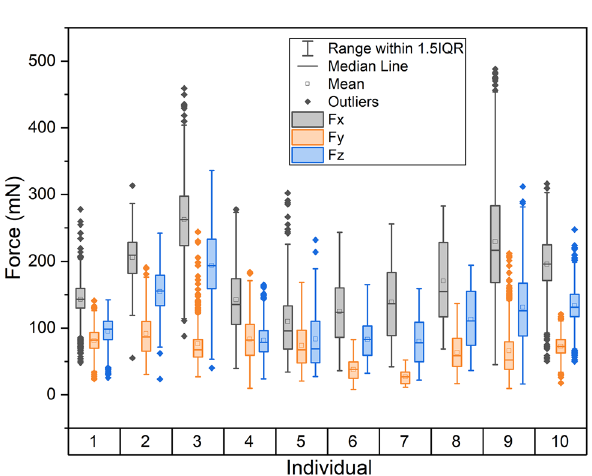
Figure 5. Force amplitudes by direction over all intervals for all individuals. Force amplitudes in the x, y, and z directions are indicated by F x , F y and F z , respectively. Individuals 1–5 were tested on the plastic post, and individuals 6–10 were tested on the carbon fiber post. Individuals 1–10 had 711, 244, 390, 1336, 136, 379, 35, 100, 693 and 1122 measurement intervals,